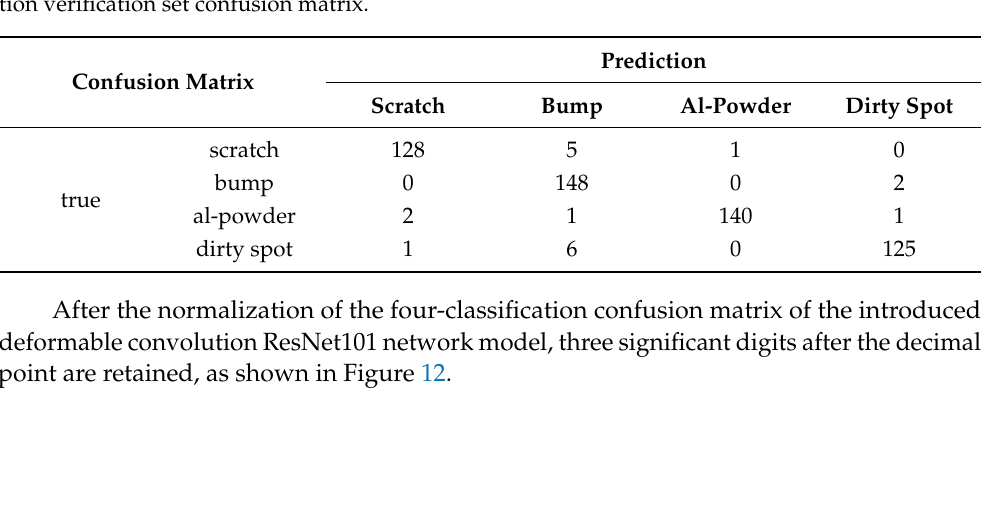
Table 4. Fusion of deformable convolution and deep residual network surface defect image classifica- tion verification set confusion